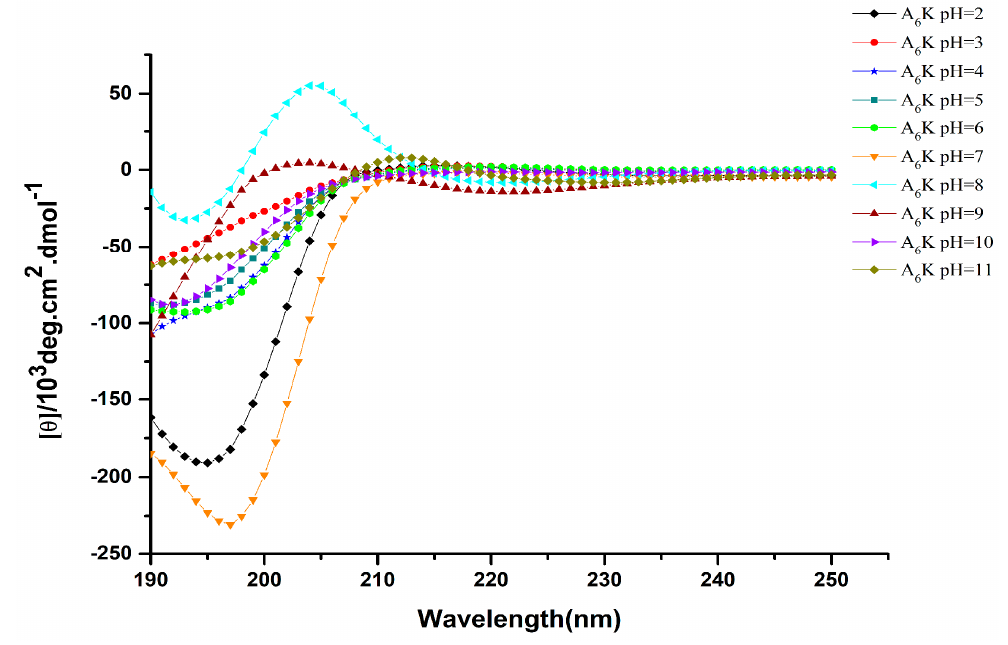
Figure 3. Circular dichroism (CD) spectra of 16 mM peptide A 6 K at different pH.